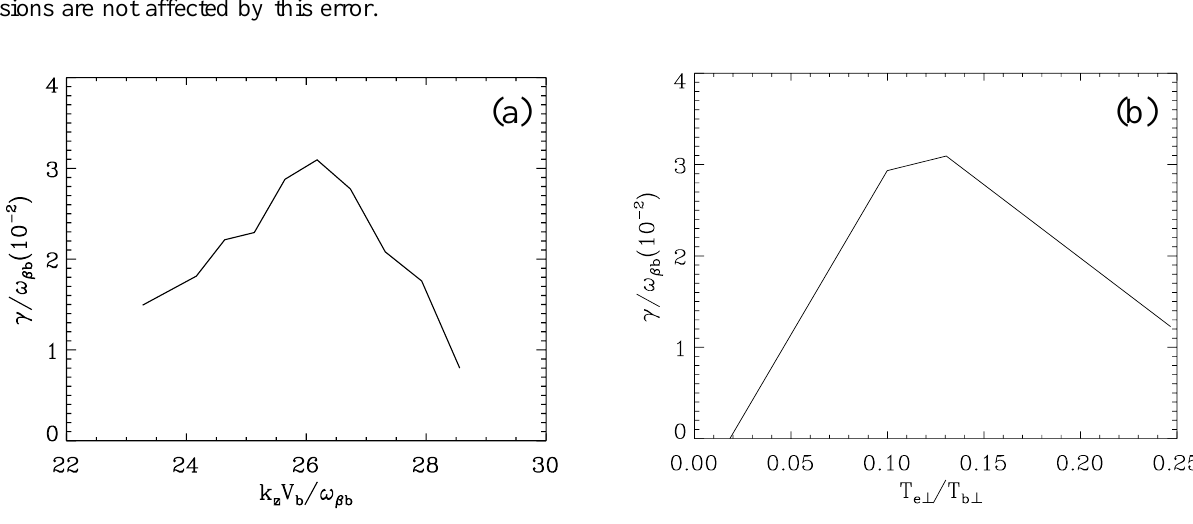
1098-4402 (cid:1) 00 (cid:1) 3(10) (cid:1) 109901(1)$15.00 © 2000 The American Physical Society